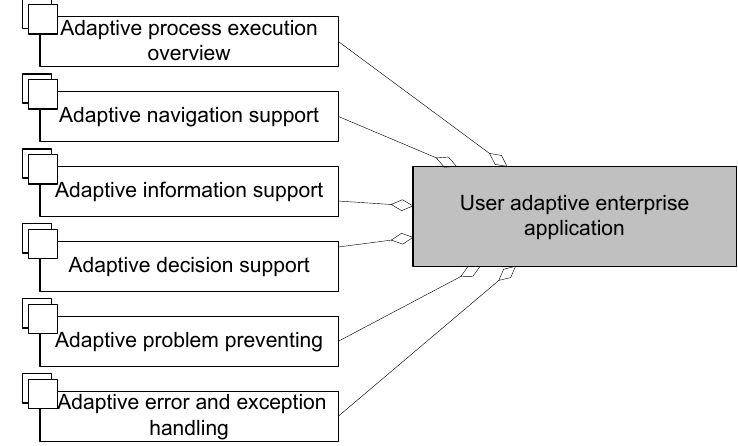
Figure 9. Model of UAEA adapted objects